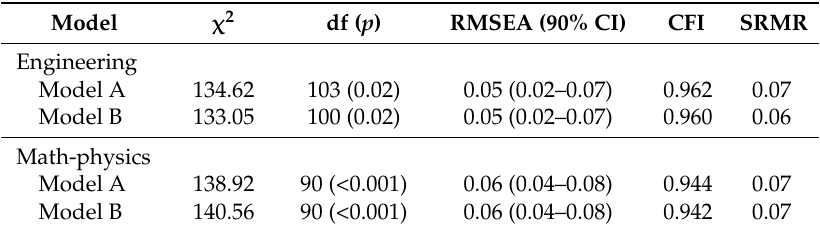
Table 10. Fit statistics for models A and B in each